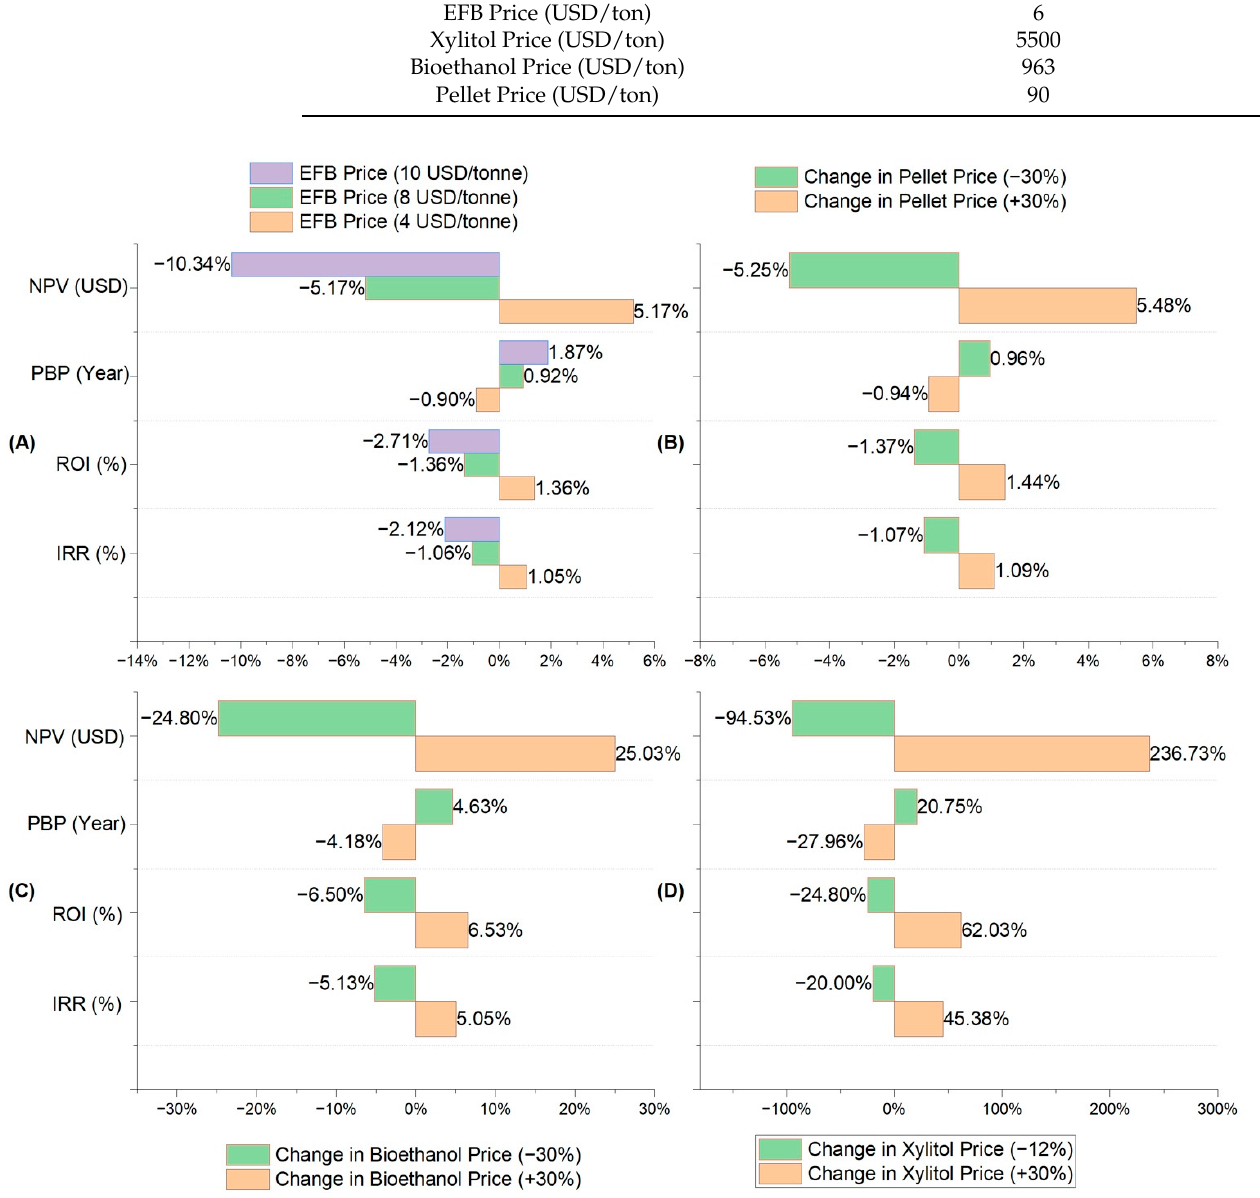
Figure 5. Sensitivity analysis of price changes in ( A ) EFB; ( B ) pellet; ( C ) bioethanol; and ( D ) xylitol at the basis of EFB splitting ratio of 30% to pellet production and MARR of 16%.